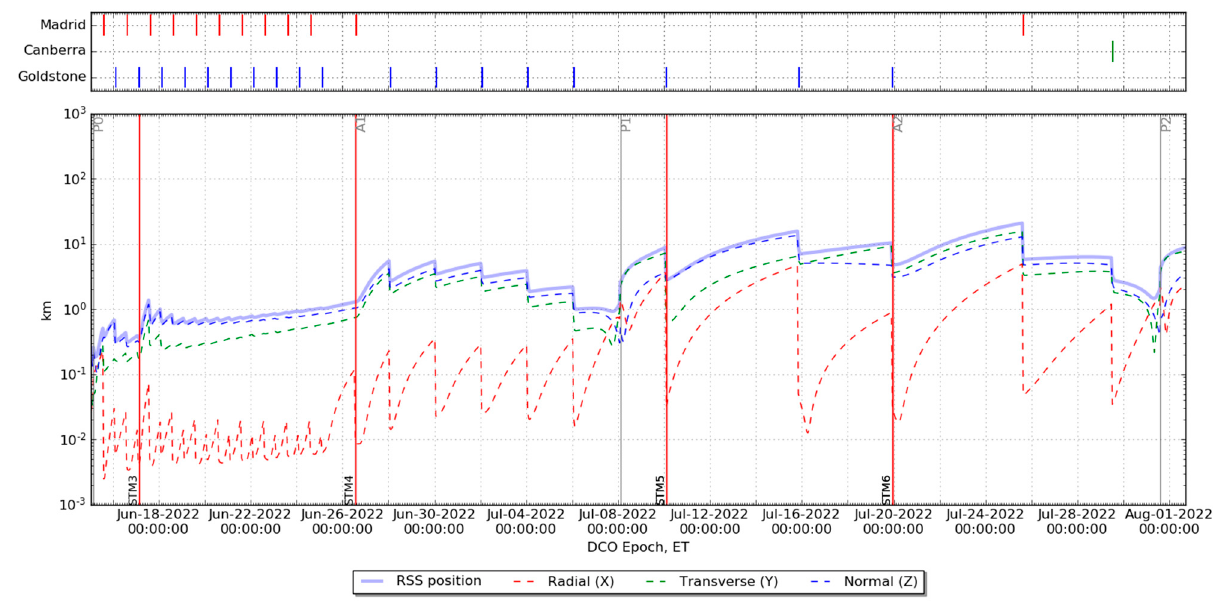
Figure 15. Position uncertainty evolution (3-sigma) from P0 to P2, in the Earth-centered RTN frame.